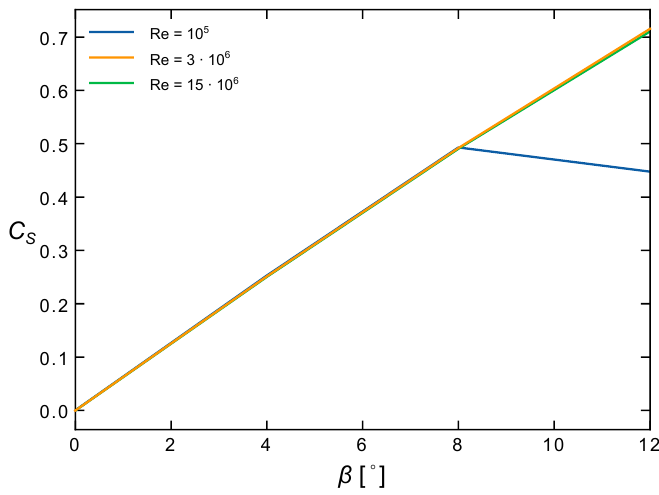
Figure 17. Side force coefficient as a function of the side-slip angle for α = 12 ◦ , taken from [23]. The relationship seems to be